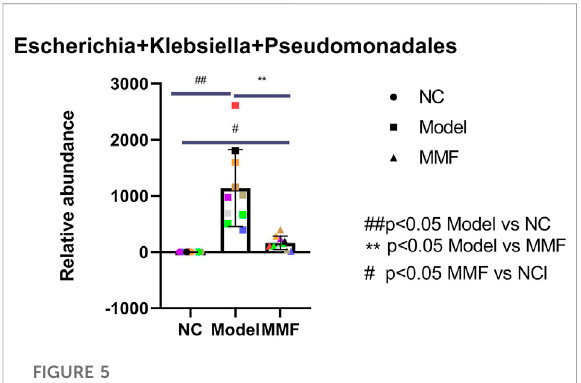
FIGURE 5 Content of pathogenic fl agellated bacterias in feces of rats in each group.